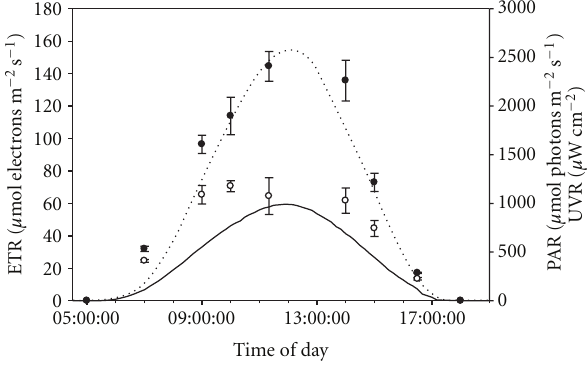
Figure 5: Daily changes in electron transport rates (ETR) of plants grown on the water table for 14 days under control filters (open circles) or UV filters (closed circles), and PAR (400–700 nm) measured above the plants on the water table (full line) and UVR (300–400 nm) under the control filter (dotted line; there was no measurable UVR under the UV filter). Data points are means of 8 replicates ± SD.